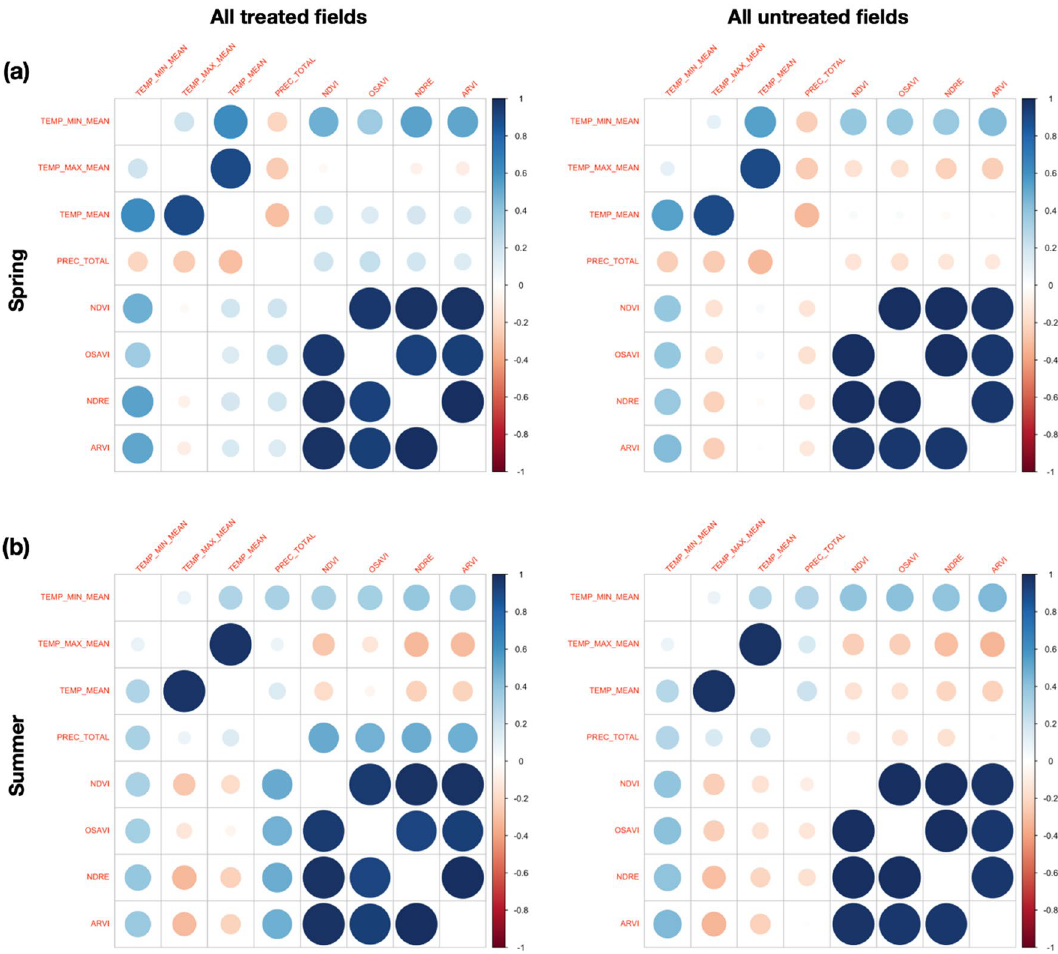
Figure 10. Pearson correlation values between S-2 spectral indices (2015–2020), temperature (min, max, mean values) and total rain precipitation ( a ) from March to May; ( b ) from June to August in all treated and untreated